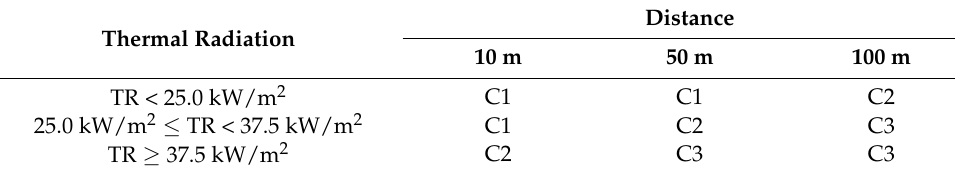
Table 6. Matrix of consequence.